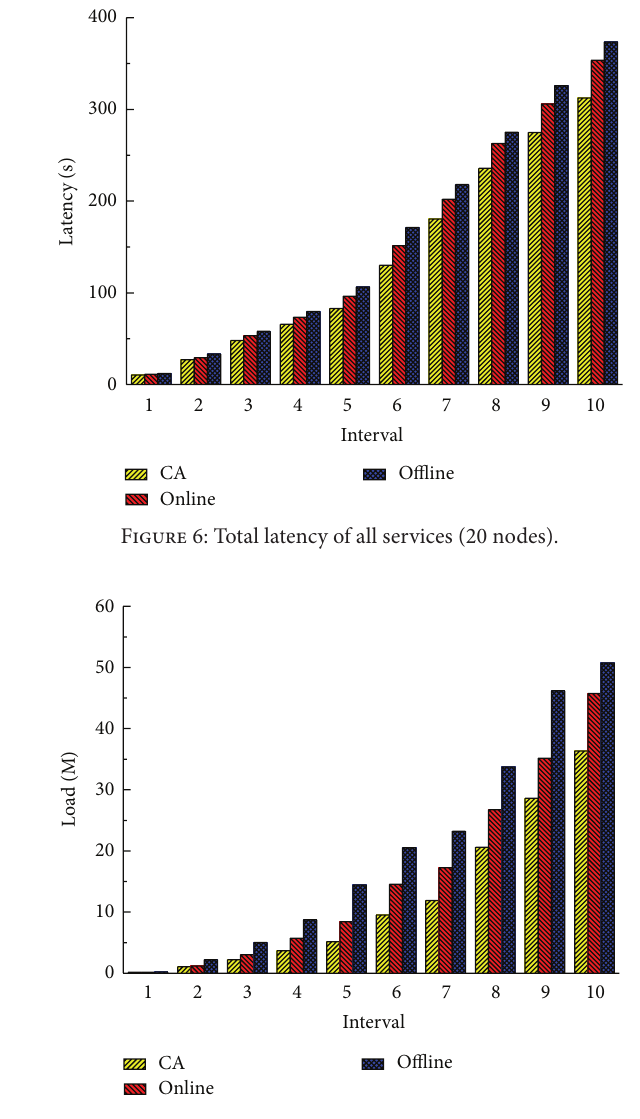
Figure 7: Total load of communication (20